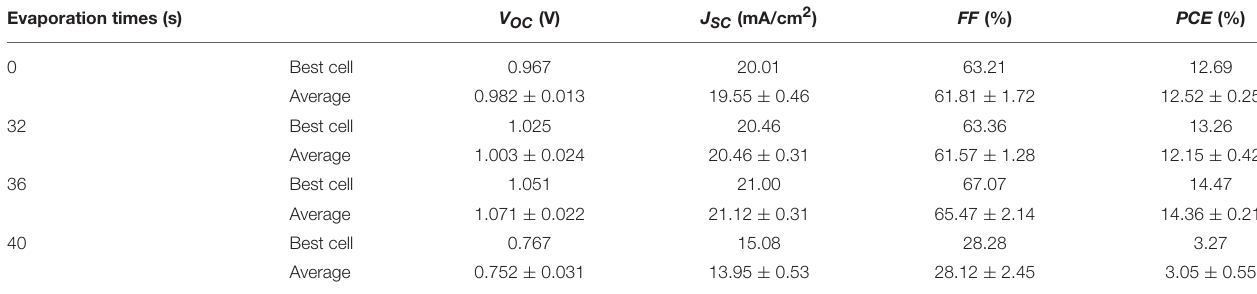
TABLE 1 | The photovoltaic parameters of the perovskite solar cells with varying BCP evaporation times. Evaporation times (s)